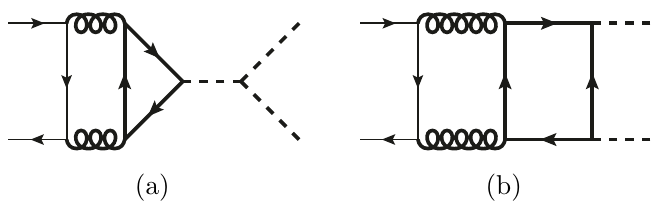
Figure 15 . Sample Feynman diagrams for the process q ¯ q → HH